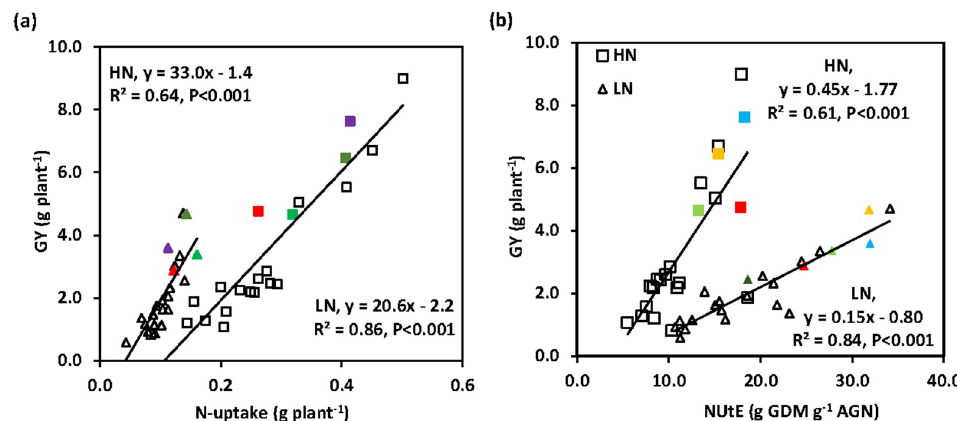
Fig 3. Linear regression of grain yield (GY, 100% DM) on ( a) N uptake plant -1 and (b) N-utilization efficiency (g grain dry matter (GDM) per g above-ground N (AGN)) at harvest under high N ( ^ ) and low N ( 4 ) conditions in 22 genotypes (18 amphidiploid lines, 4 bread wheat parents, parents in colour symbols (Red: Pavon 76, Blue: Highbury, Green: Paragon, Orange: Chinese Spring) (mean 2015 and 2016).